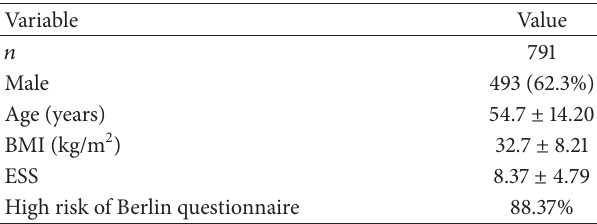
Table 1: Demographic characteristics of the population studied. Values are expressed as media and standard